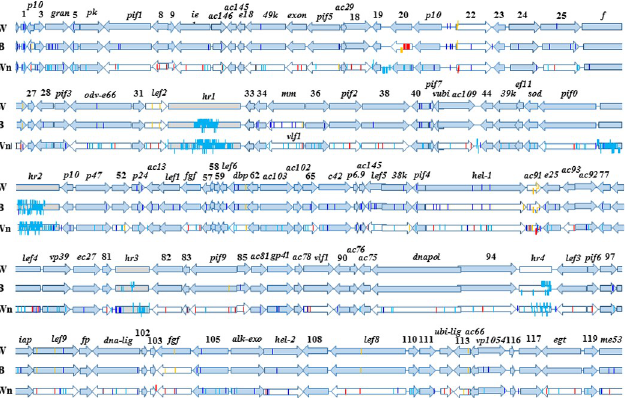
Fig 1. Comparison of genome structure between PlxyGV-W, PlxyGV-B, and PlxyGV-Wn. The figure depicts a schematic representation of the PlxyGV genomes with map positions of the 118 ORFs represented by arrows indicating transcriptional direction and relative size. Numbers above arrows represent the number of each ORF. Blue and orange vertical lines represent the locations of synonymous and nonsynonymous nucleotide polymorphisms respectively. Light blue and red vertical lines represent the locations of synonymous and nonsynonymous point mutations in the PlxyGV-B and PlxyGV, compared to PlxyGV-W. Raised lines represent insertions and the lowered lines represent deletions. Turning lines represent frameshift mutations. hr sequences and their positions on the genome are indicated by light grey boxes. Empty arrows represent ORFs with nonsynonymous mutations relative to